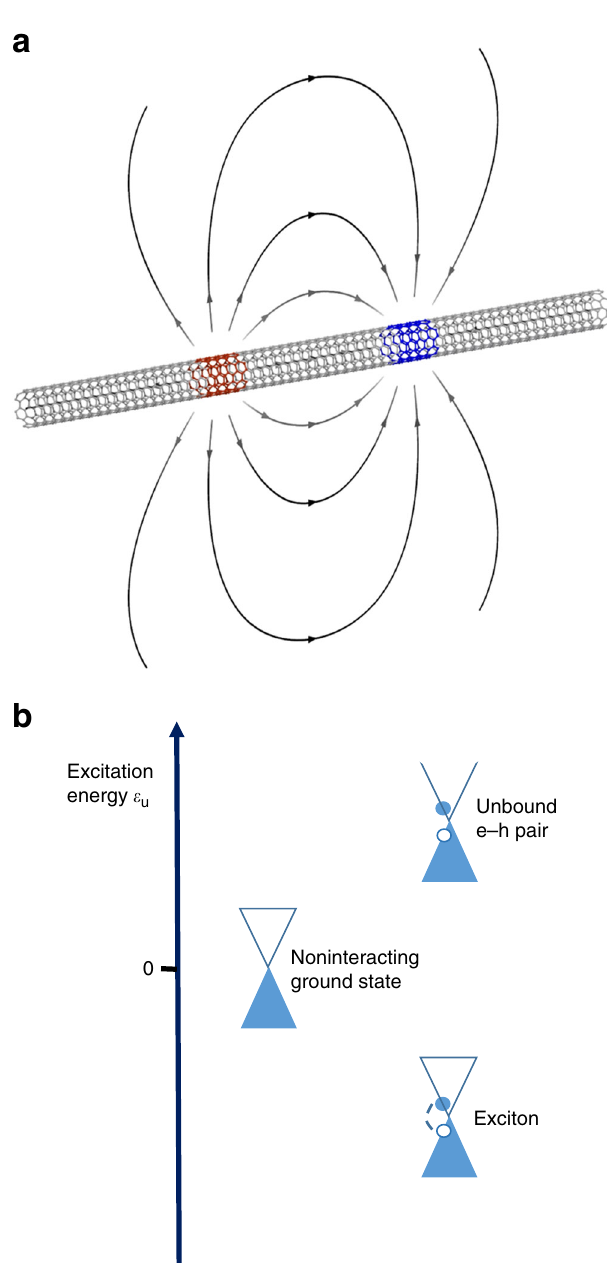
Fig. 1 Excitonic instability in carbon nanotubes. a Sketch of a suspended armchair carbon nanotube. The fi eld lines of the Coulomb force between electron and hole lie mainly in the vacuum, hence screening is heavily suppressed. b Excitonic instability in the armchair carbon nanotube. The scheme represents the excitation energy ε u of an electron – hole (e – h) pair relative to the noninteracting ground state, a zero-gap semiconductor. In the absence of interaction, the excitation energy ε u of an e – h pair is positive. The long-range interaction may bind e – h pairs close to the Dirac point in momentum space. If an exciton forms, then its excitation energy ε u is negative. This instability leads to the reconstruction of the ground state